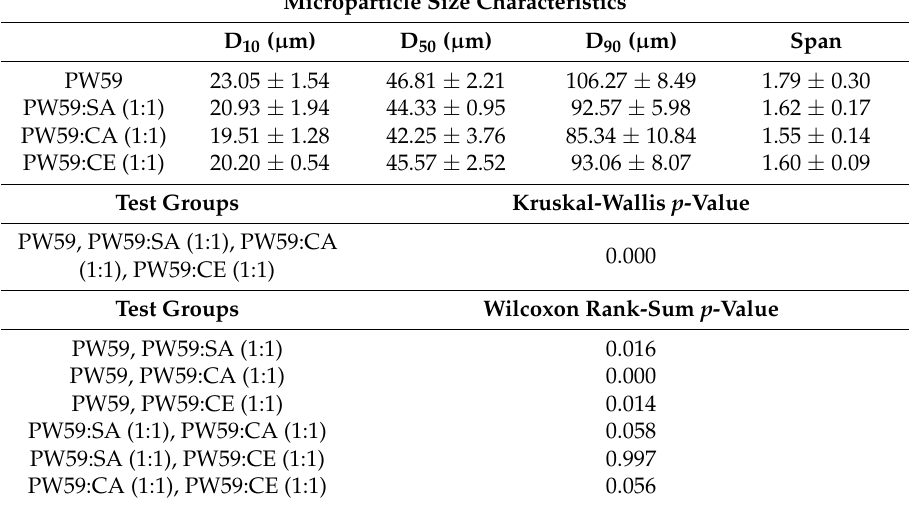
Table 4. Results of microparticle size characteristics ( n = 3), Kruskal-Wallis test, and Wilcoxon rank-sum